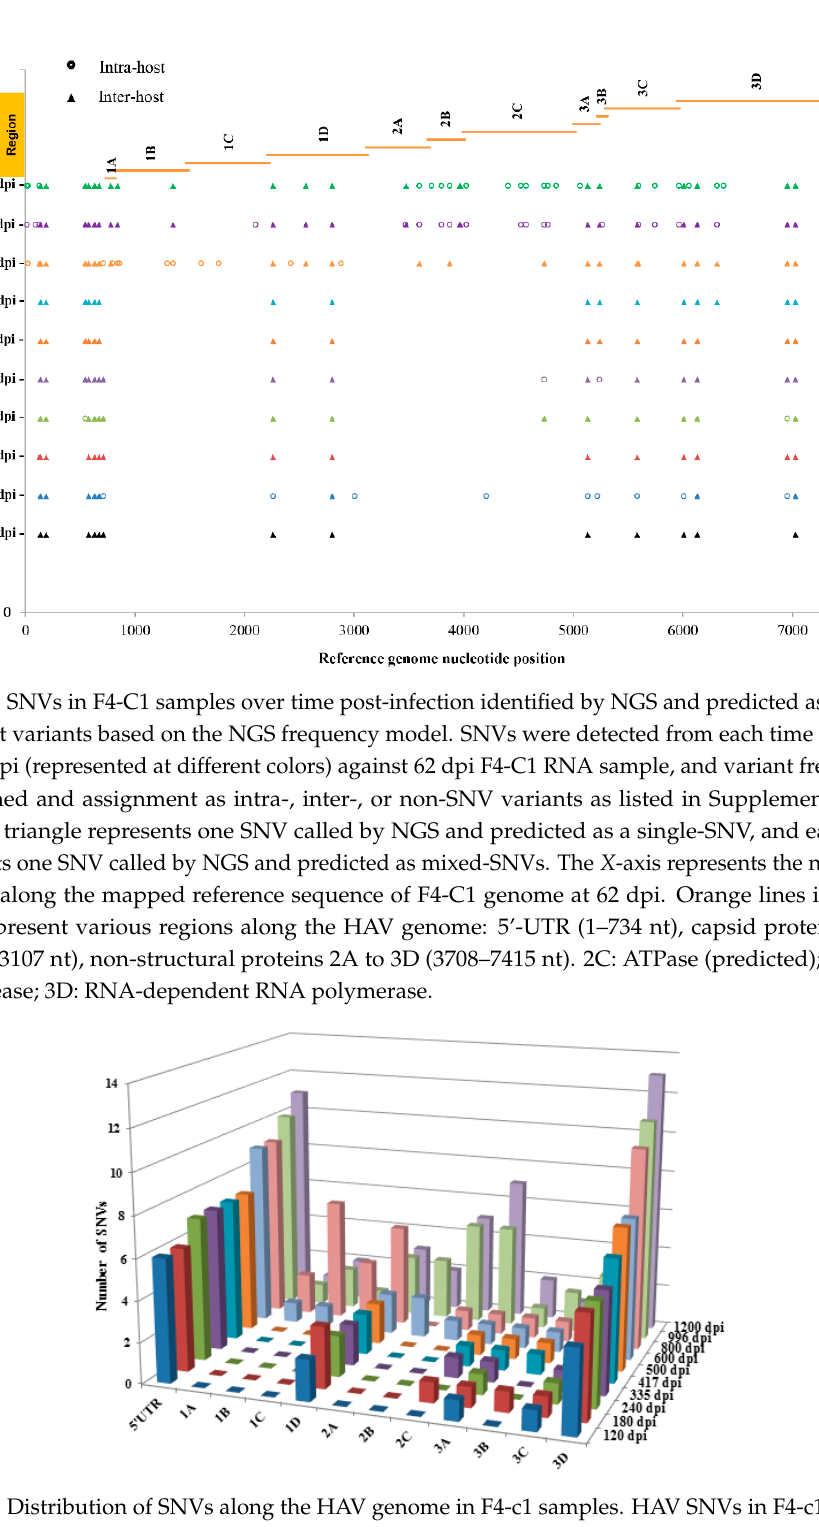
Figure 4. Distribution of SNVs along the HAV genome in F4-c1 samples. HAV SNVs in F4-c1 samples were detected from each time point 120 to 1200 dpi (represented as different colors) against 62 dpi. X -axis represents different regions (not in proportion) along the mapped reference sequence of F4-C1 genome at 62 dpi. Y -axis represents the number of SNVs in each region. Z -axis represents the different time points at days post infection.